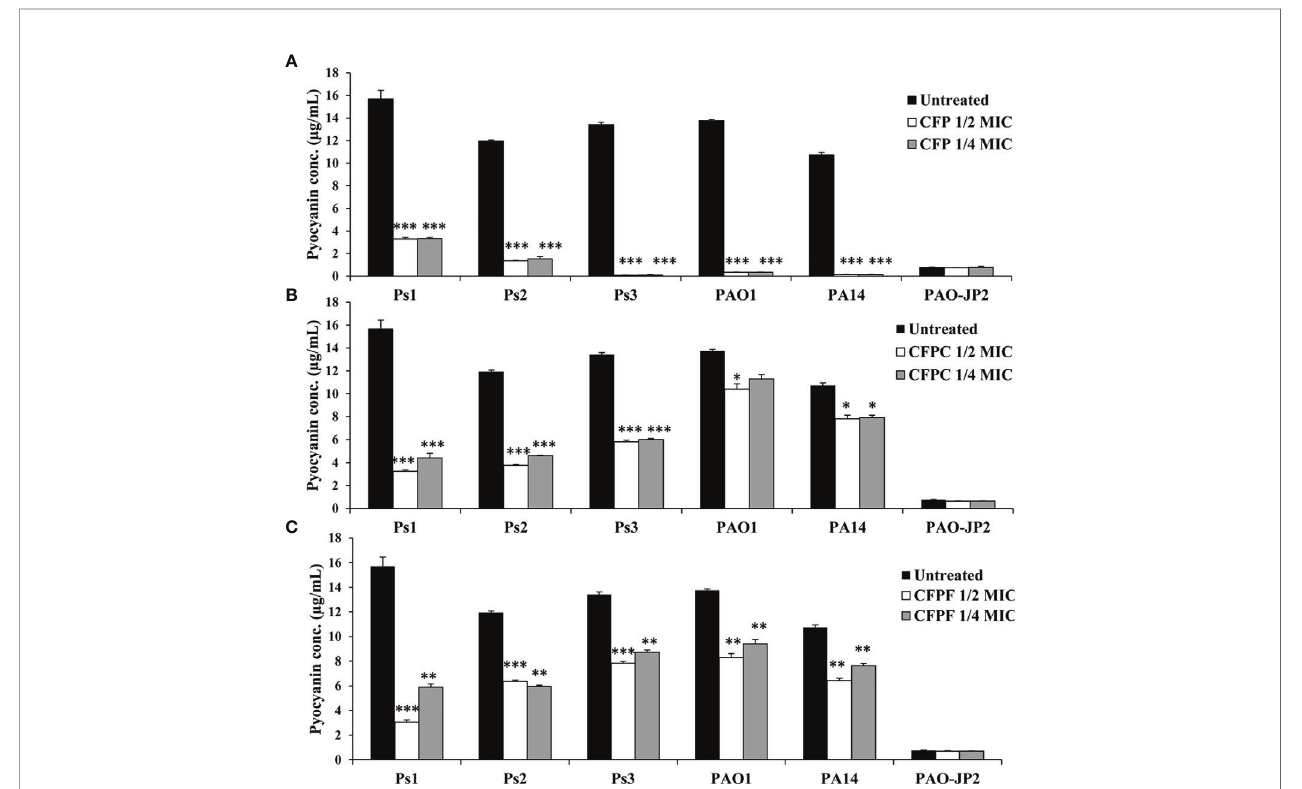
FIGURE 1 | Pyocyanin production; Effect of sub-MICs; 1/4 and 1/2 of Cefoperazone (CFP) (A) Cefoperazone-Cobalt complex (CFPC) (B) and Cefoperazone-Iron complex (CFPF) (C) on pyocyanin production in P. aeruginosa strains, Ps1, Ps2, Ps3, PAO1, PA14 and PAO-JP2 (negative control) compared to the untreated cultures. Error bars represent S.D. (n = 3), * p ≤ 0.05, ** p ≤ 0.01, and *** p ≤